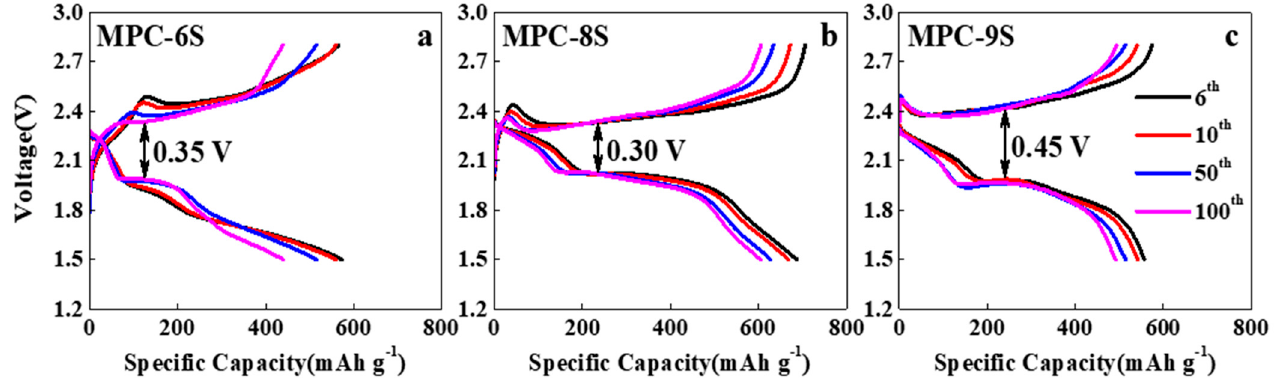
Figure 5. ( a – c ) Charge-discharge voltage profiles of the MPC-6S, MPC-8S and MPC-9S cells after cycling